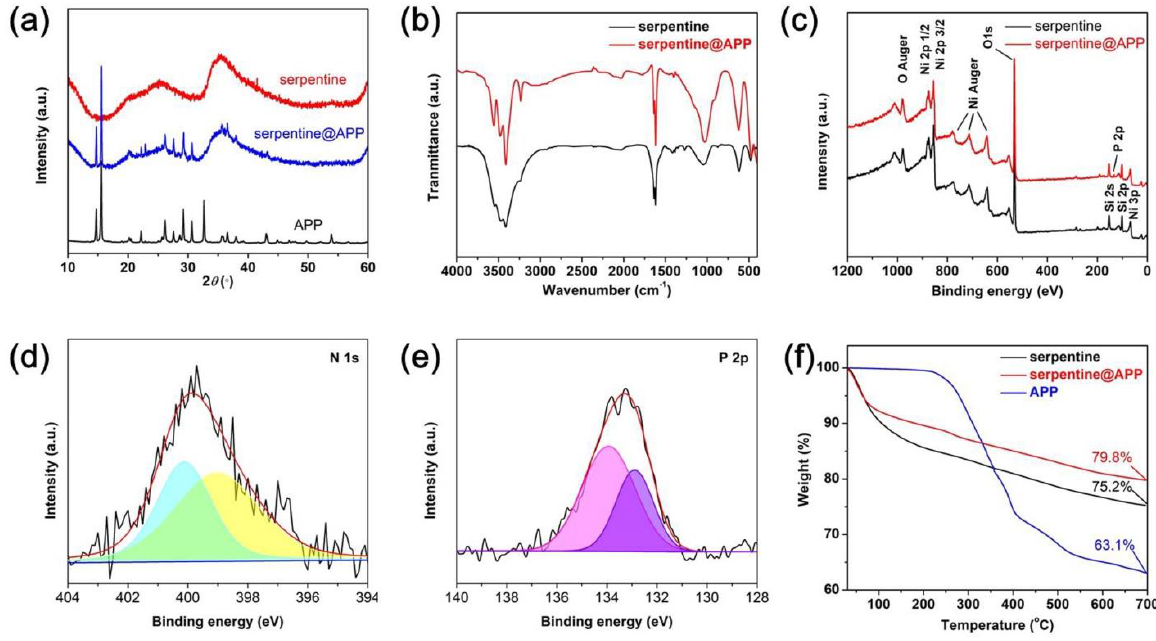
Figure 2. ( a ) XRD patterns ( b ) FT-IR spectra ( c ) XPS full scan spectra of serpentine and serpen- tine@APP; ( d ) N 1s, ( e ) P 2p high-resolution spectra of serpentine@APP, and ( f ) TGA curves of APP, serpentine, and